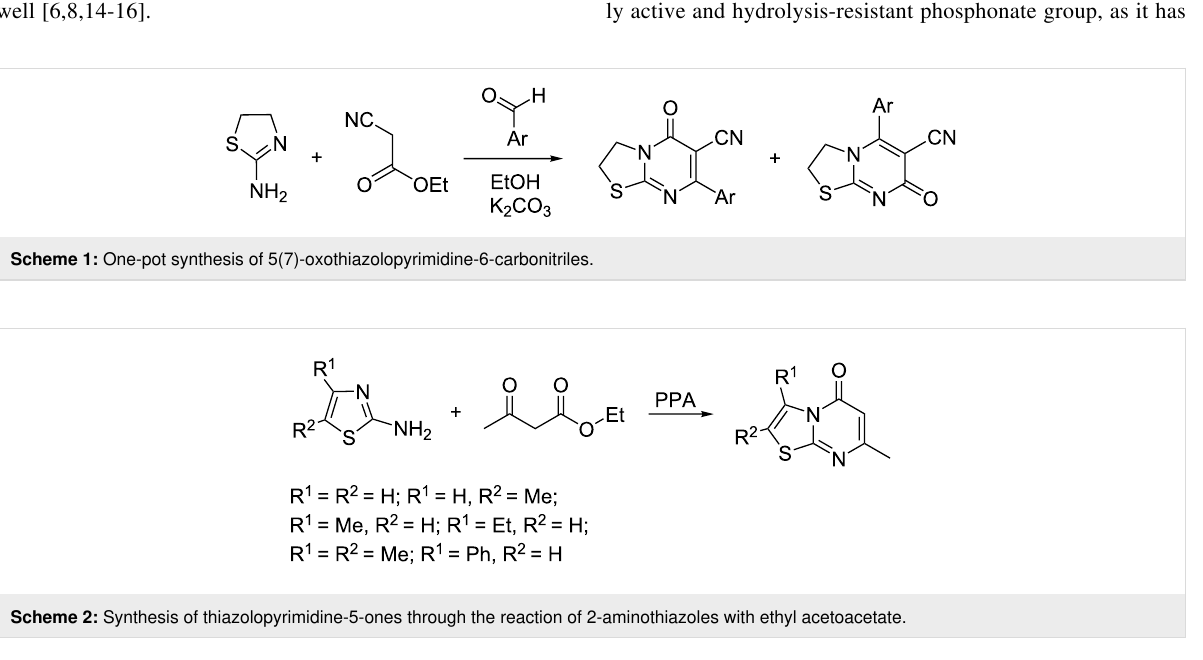
The synthesis of thiazolopyrimidines through the reaction of 2-aminothiazoles with 1,3-ketoesters in the presence of acids, bases or condensing agents (Scheme 2) has been studied fairly well